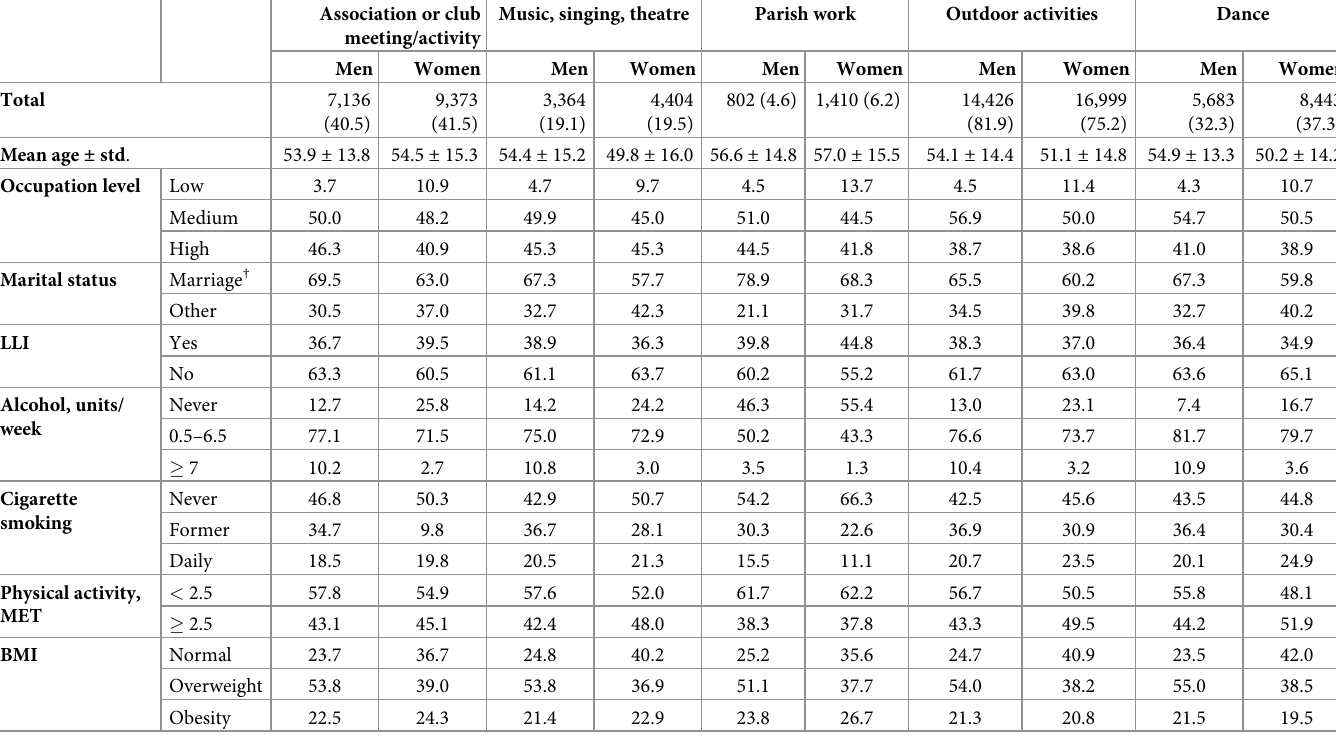
Table 2. Gender-specific distribution (%) of participants in terms of engagement in each creative cultural activity (n = 40,214). The HUNT Study (2006–08). Association or club Music, singing, meeting/activity